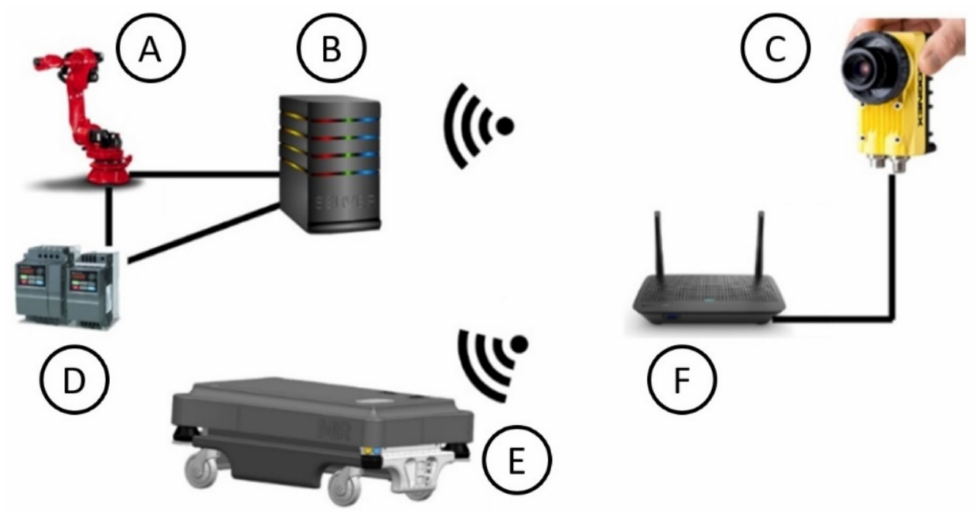
Figure 5. Shows the IIoT communication infrastructure which consists of both wired and wireless communication. Wired communication is conducted between an IRC 5 OPC DA server ( A ), an OPC UA server ( B ), and a safety PLC OPC UA server ( D ). Wired communication is also conducted between a Cognex D900 camera ( C ) and a Wi Fi router (F) to enable ( C ) for wireless connections. Wireless two-way communication is conducted between the OPC UA server ( B ) to ( C ) to ( E ). ( C ) and ( E ) are not communicating to each other